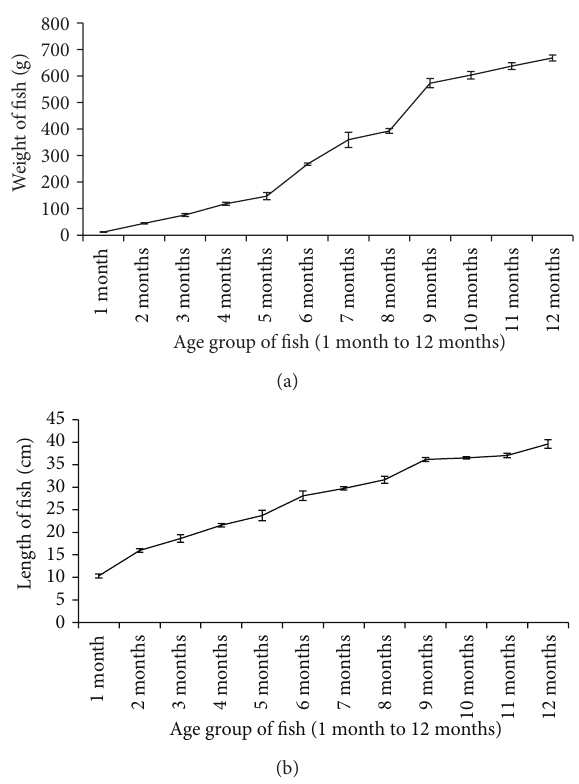
Figure 1: Monthly growth of Labeo rohita from 1 month to 12 months of age. (a) Mean weight of fish. (b) Mean length of fish. Values are expressed as mean ± SEM ( 𝑁 = 6